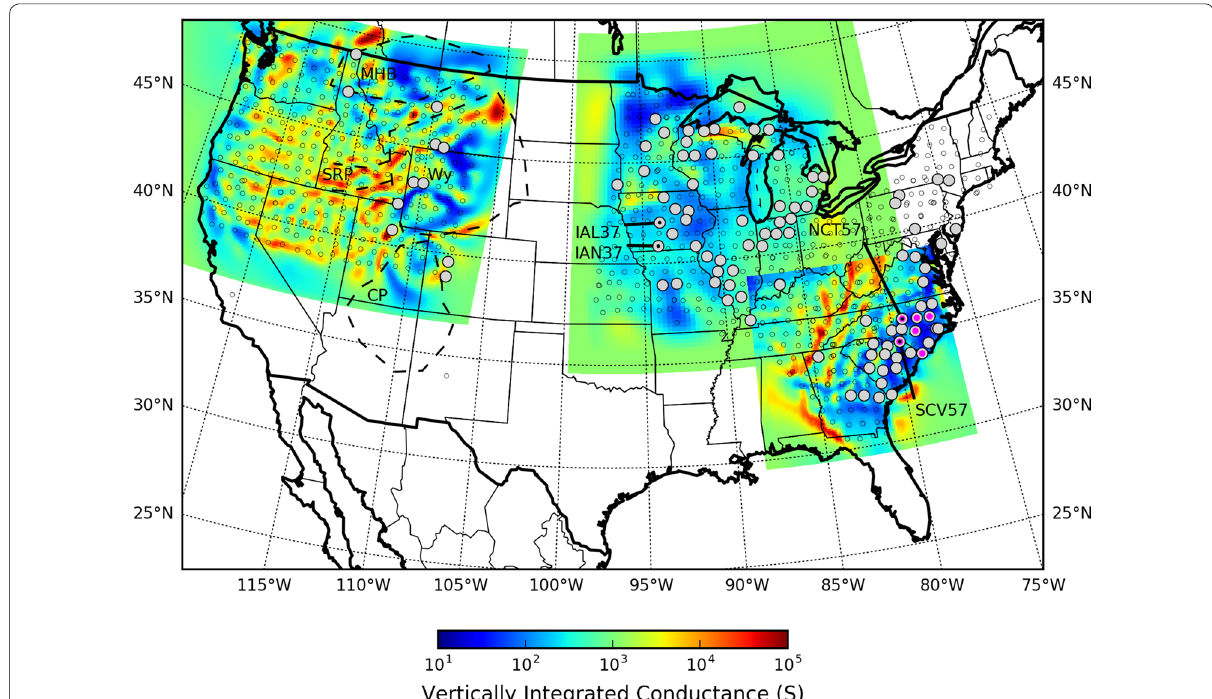
Fig. 1 Map showing distribution of EarthScope MT sites identified as clearly showing source bias (gray filled circles), plotted over vertically inte- grated Earth conductance (15–150 km) calculated from the inverse solutions of Meqbel et al. (2014) (northwestern USA), Yang et al. (2015) (north- central USA), and Murphy and Egbert (2017) (southeastern USA). For reference, the conductance of constant 100 Ωm Earth between 15 and 150 km would be 1350 S. Markers with purple centers are sites used in the array analysis shown in Fig. 3. Markers with black dots in the center are sites used in the cross-phase analyses shown in Fig. 2. Hollow circles show all available EarthScope MT sites as of this writing. Key geologic features in the northwestern USA that are discussed in the text are shown on the map as well. MHB Medicine Hat Block; Wy Wyoming Craton; SRP Snake River Plain; CP Colorado